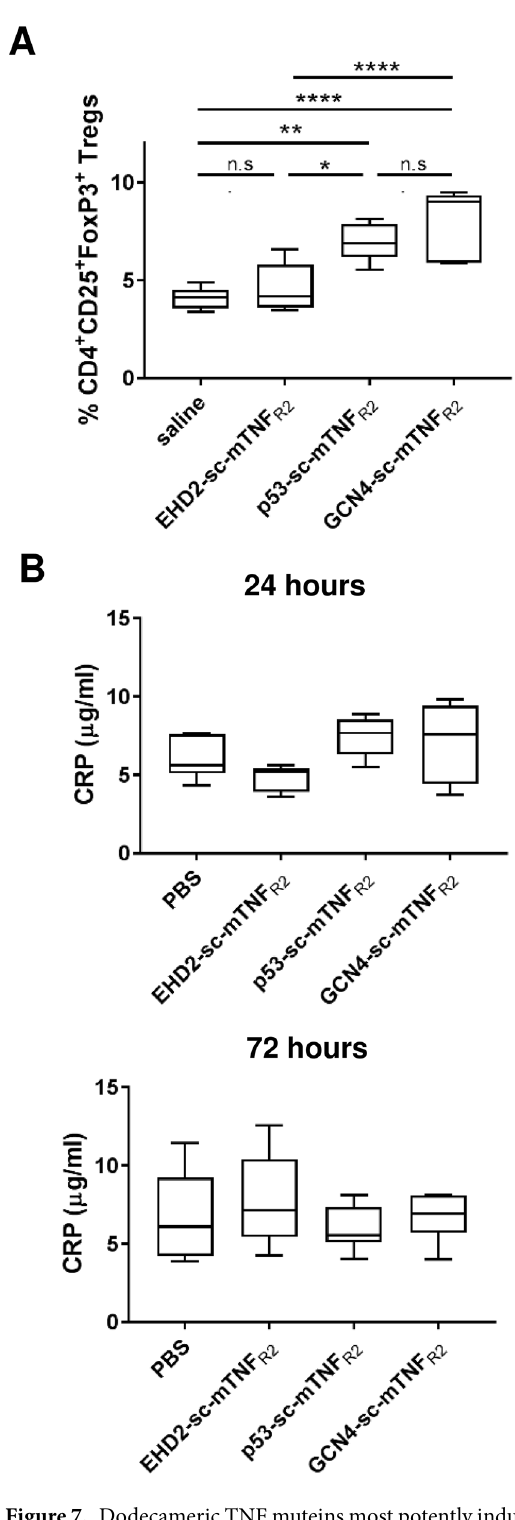
Figure 7. Dodecameric TNF muteins most potently induce T cell activation and Treg expansion C57BL/6 mice were administered with 1 mg/kg body weight (i.p.) of the proteins or saline. ( A ) After 3 days, splenocytes were isolated and number of CD4 + CD25 + FoxP3 + Tregs was determined by flow cytometry. ( B ) After 24 hours and 72 hours whole blood was withdrawn and CRP levels in the blood were determined by ELISA (n = 5–7 mice ±